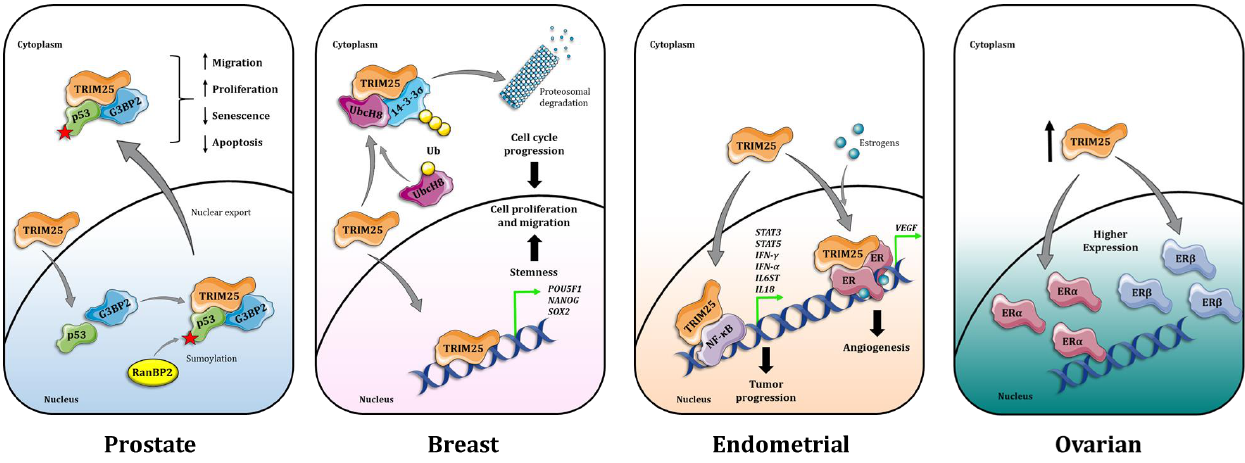
Figure 2. Diversity of TRIM25 action in hormonal cancers. In prostate cancer, TRIM25 binds to p53 and G3BP2, forming a protein complex that facilitates p53 SUMOylation by RanBP2, resulting in p53 nuclear export, increased migration and proliferation of tumor cells while decreasing senescence and apoptosis. In breast cancer, nuclear TRIM25 activates senescence genes, including POUF51, NANOG and SOX2. In addition, TRIM25 acts as an E3 ligase, enabling 14-3- 3 σ /UBCH8 interaction, leading to 14-3-3 σ polyubiquitination and degradation. These two mechanisms of action increase breast cancer cell proliferation and migration. In endometrial cancer, TRIM25 binds to NF- κ B, activating transcription of pro-tumorigenic genes, including STAT3, STAT5, IFN- γ , IFN- α , IL6ST and IL18. Upon estrogen signaling, TRIM25 interacts with ER α and activates VEGF gene transcription, enhancing angiogenesis and endometrial tumor progression. In ovarian cancer, TRIM25 is overexpressed relative to normal ovarian tissue, which correlates with increased expression of ER α and ER β